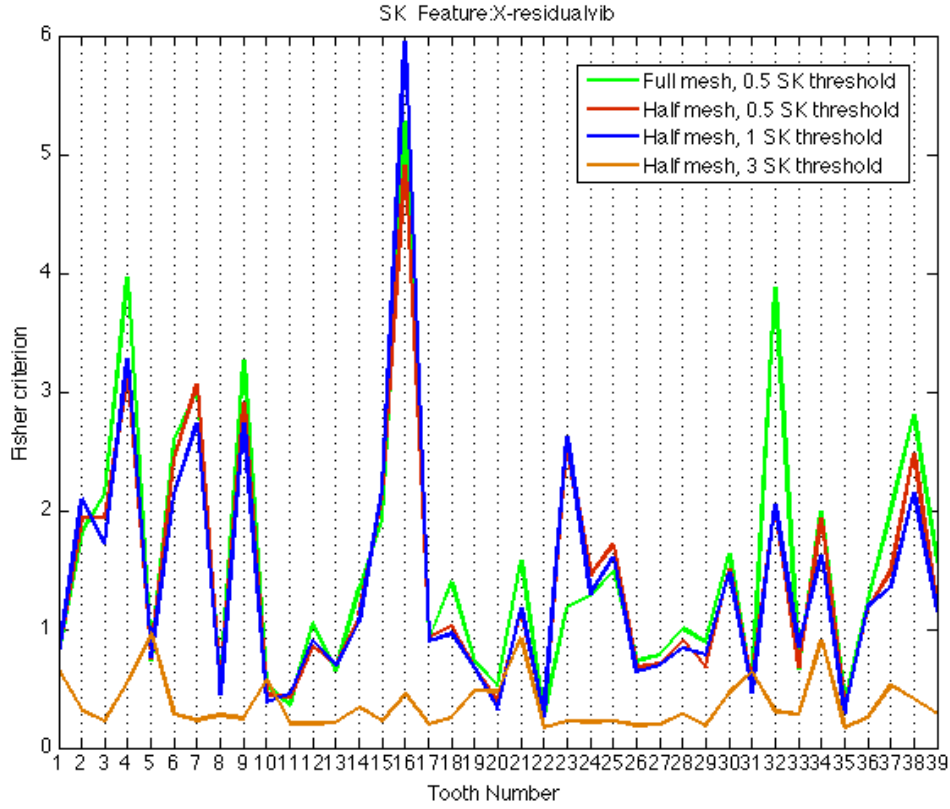
Figure 13. The FC for each tooth and combinations of SK window sizes and thresholds for SK based filtering.